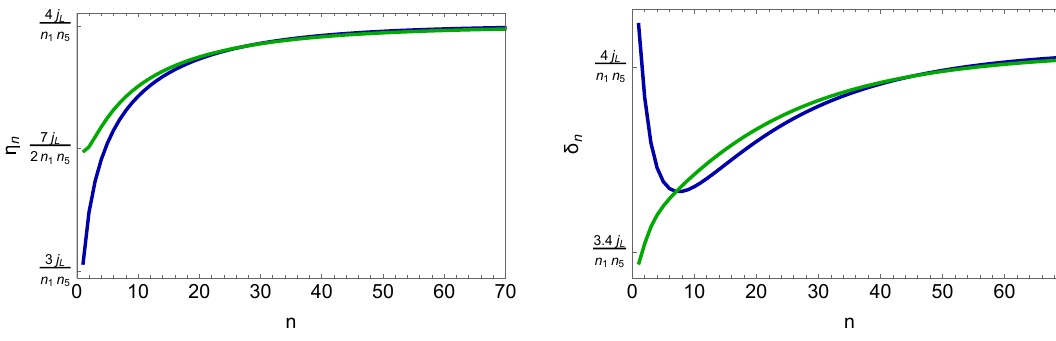
Figure 1 . The mass gap, δ n , and the energy difference between two successive normalizable modes, η n , of scalar perturbations in the (2 , 1 , n, q = 0) original superstratum solution (blue curves) and in the (2 , 1 , n, q = 1) supercharged superstratum solution (green curves) as functions of n . We have chosen particular values of integer mode parameters which corresponds to the minimum mass gap value (∆ = 10, q 1 = q 2 = 4, n y = 10). However, any other initial values give similar profiles − which converge quickly to their large- n values given by